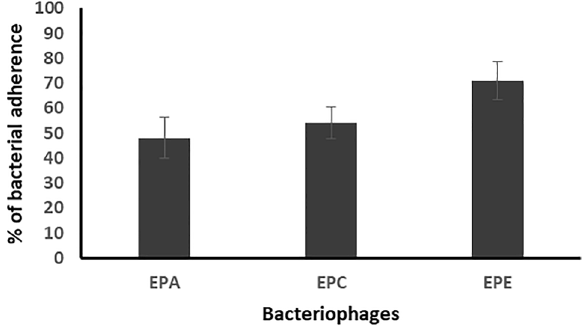
Figure 8. Percentage of bacterial adherence on the surface of catheters segments of the 3 enterococcal isolates (EF104, EF134, and EF151), prepared in dilution 1/500 from bacterial suspension adjusted to 0.5